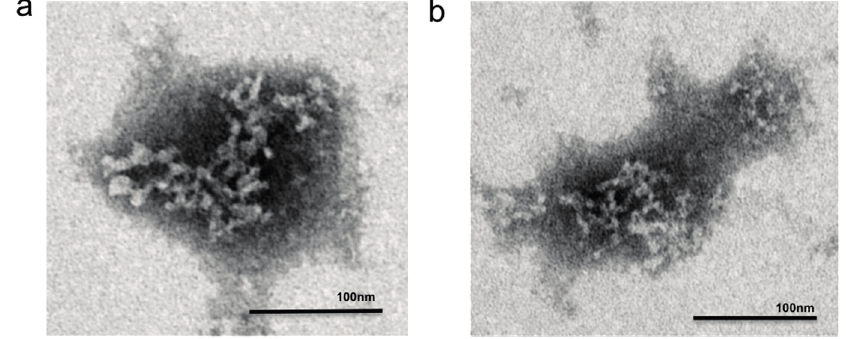
Figure 1. Schematic representation of ( a ) the DNA/Enzyme Nanostructure with conjugated tyrosinase tetramers and ( b ) nanosensor mechanism.